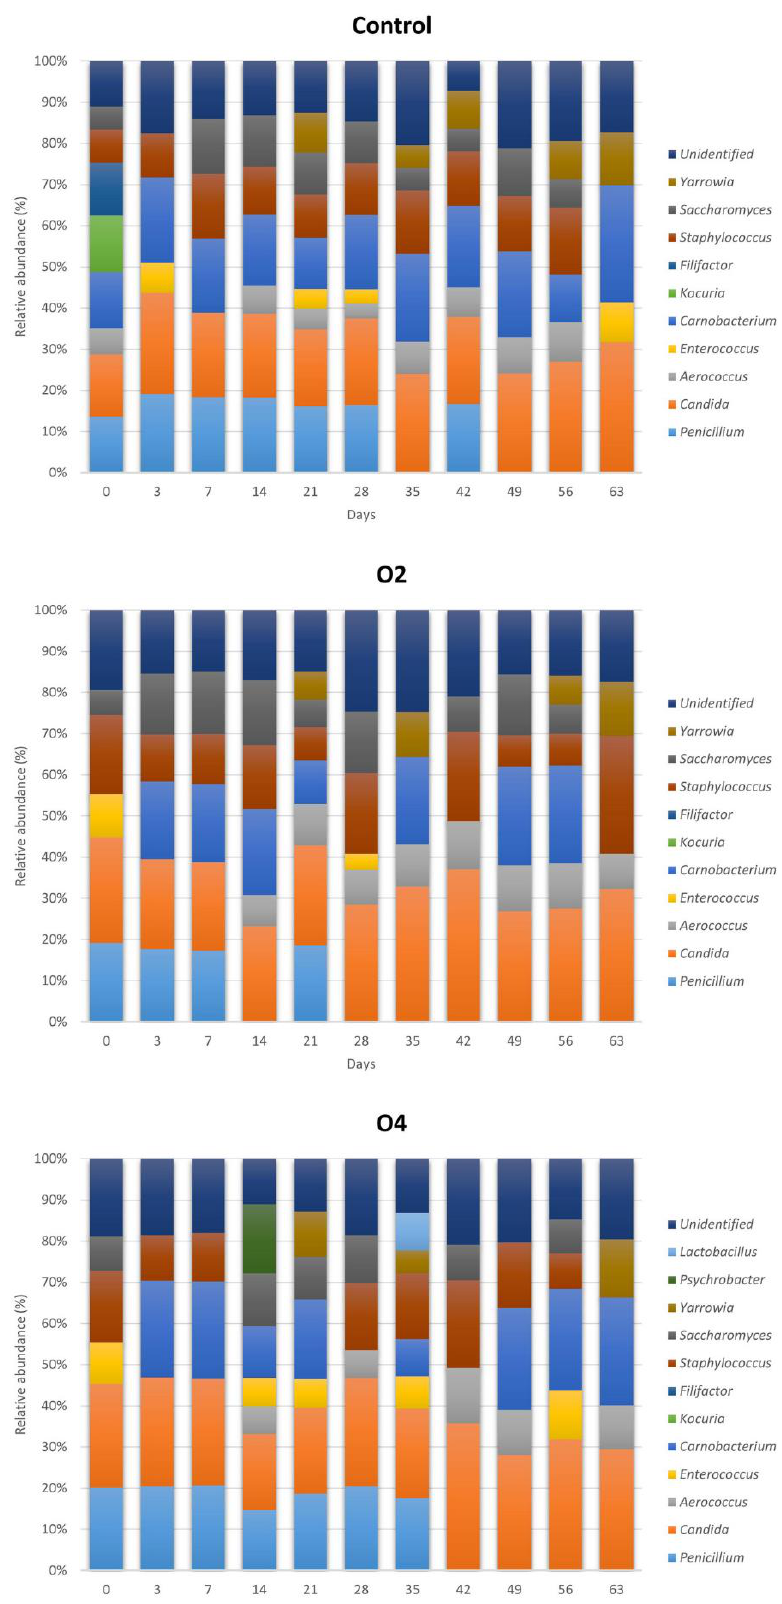
Figure 3. Relative abundances (%) of different microbial genera in control and ozone-treated (O2 and O4) rind samples during storage at 4 °C.